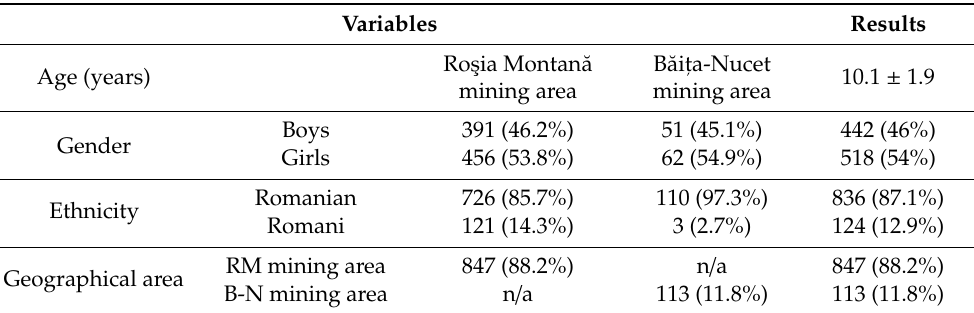
Table 1. Demographic data of subjects within the